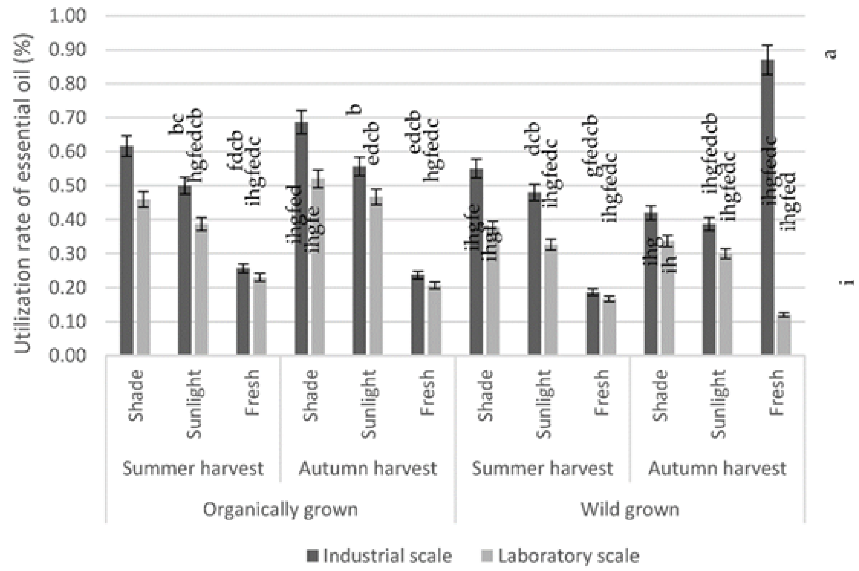
Figure 2. The influence of the analyzed factors on the utilization rate of the essential oil. (The bars designated by different small letters (a, b, c, d, e, f, g, h, i, j) are significantly different ( p < 0.05)). Table 2. Results of the analysis of the variance of the influence of the analyzed factors on the utilization rate of the essential oils in immortelle at a significance level of p < 0.05.